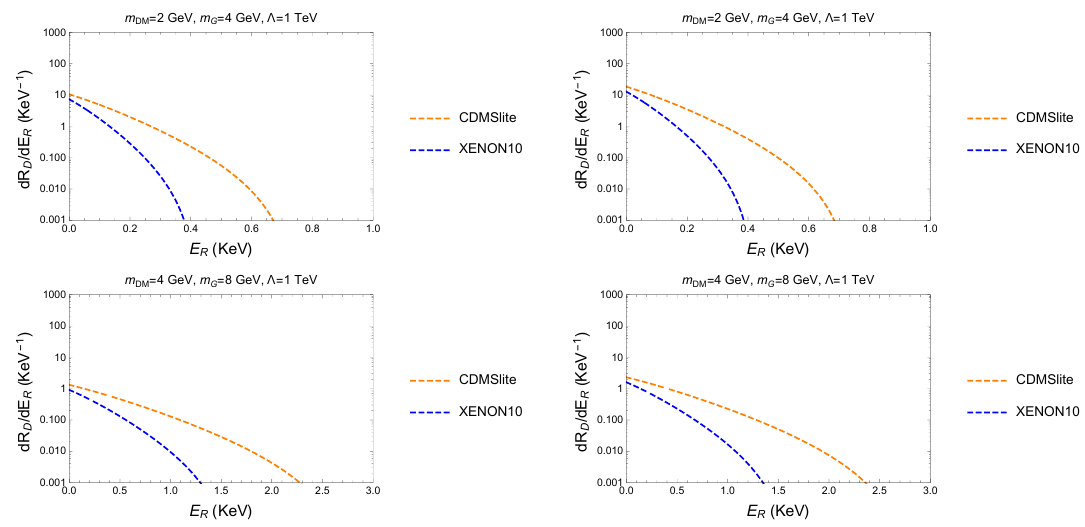
Figure 8 . Di(cid:11)erential event rates for light fermion (left) or scalar (right) dark matter for current experiments for (cid:3) = 1 TeV and c (cid:31) = c =